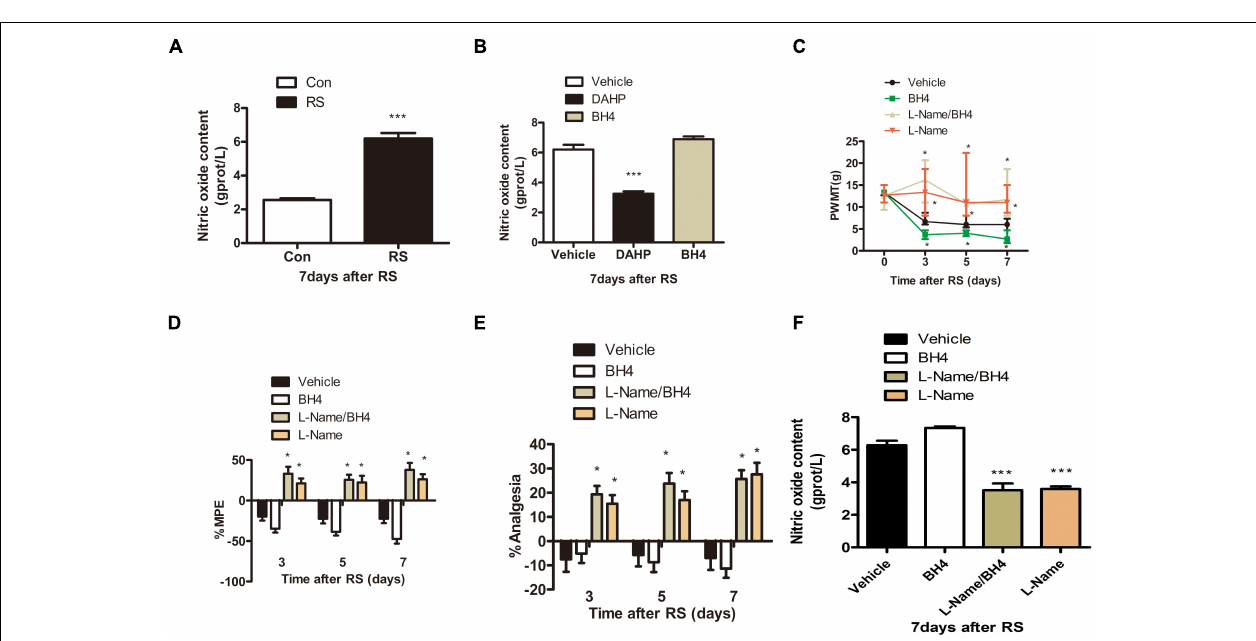
FIGURE 4 | The expression of spinal NO in the rats subjected or not subjected to chronic RS and effect of L -NAME on the nociceptive behavior and spinal NO in the rat models of RS. (A) The expression of spinal NO in the rats subjected or not subjected to chronic RS, P < 0.001. (B) Effects of either DAHP or BH4 intrathecal administration on spinal NO in rats subjected to chronic RS. Chronic RS rats received chronic intrathecal treatment with either DAHP (6 mg/kg) or BH4 (1 µ g/ml, 10 µ l) from the first day of establishing chronic RS until the end of the experiment, F 2 , 15 = 67.94, P < 0.001. (C–E) Effect of L -NAME intrathecal administration on nociceptive behavior in rats subjected to chronic RS; chronic RS rats that received chronic intrathecal treatment with L -NAME (30 µ g/ µ l, 10 µ l) 30 min prior to BH4 (1 µ g/ml, 10 µ l), L -NAME (30 µ g/ µ l, 10 µ l), and BH4 (1 µ g/ml, 10 µ l) treatment. Nociceptive behavior tests including PWMT (treatment: F 3 , 33 = 47.94, P < 0.001; observation intervals: F 3 , 99 = 49.132, P < 0.001; interaction: F 9 , 99 = 16.453, P < 0.0001), PWTL (treatment: F 3 , 33 = 34.594, P < 0.001, observation intervals: F 2 , 66 = 1.131, P = 0.329; interaction: F 6 , 66 = 3.15, P = 0.009), and TFL (treatment: F 3 , 33 = 22.943, P < 0.001; observation intervals: F 2 , 66 = 1.598, P = 0.21; interaction: F 6 , 66 = 2.904, P = 0.014). (F) Effect of intrathecal administration of L -NAME on the expression of spinal NO, F 3 , 20 = 51.906, P < 0.001. *Significant difference with respect to control or vehicle groups (two-way ANOVA with repeated measures). * P < 0.05 and *** P < 0.001. NO, nitric oxide; RS, restraint